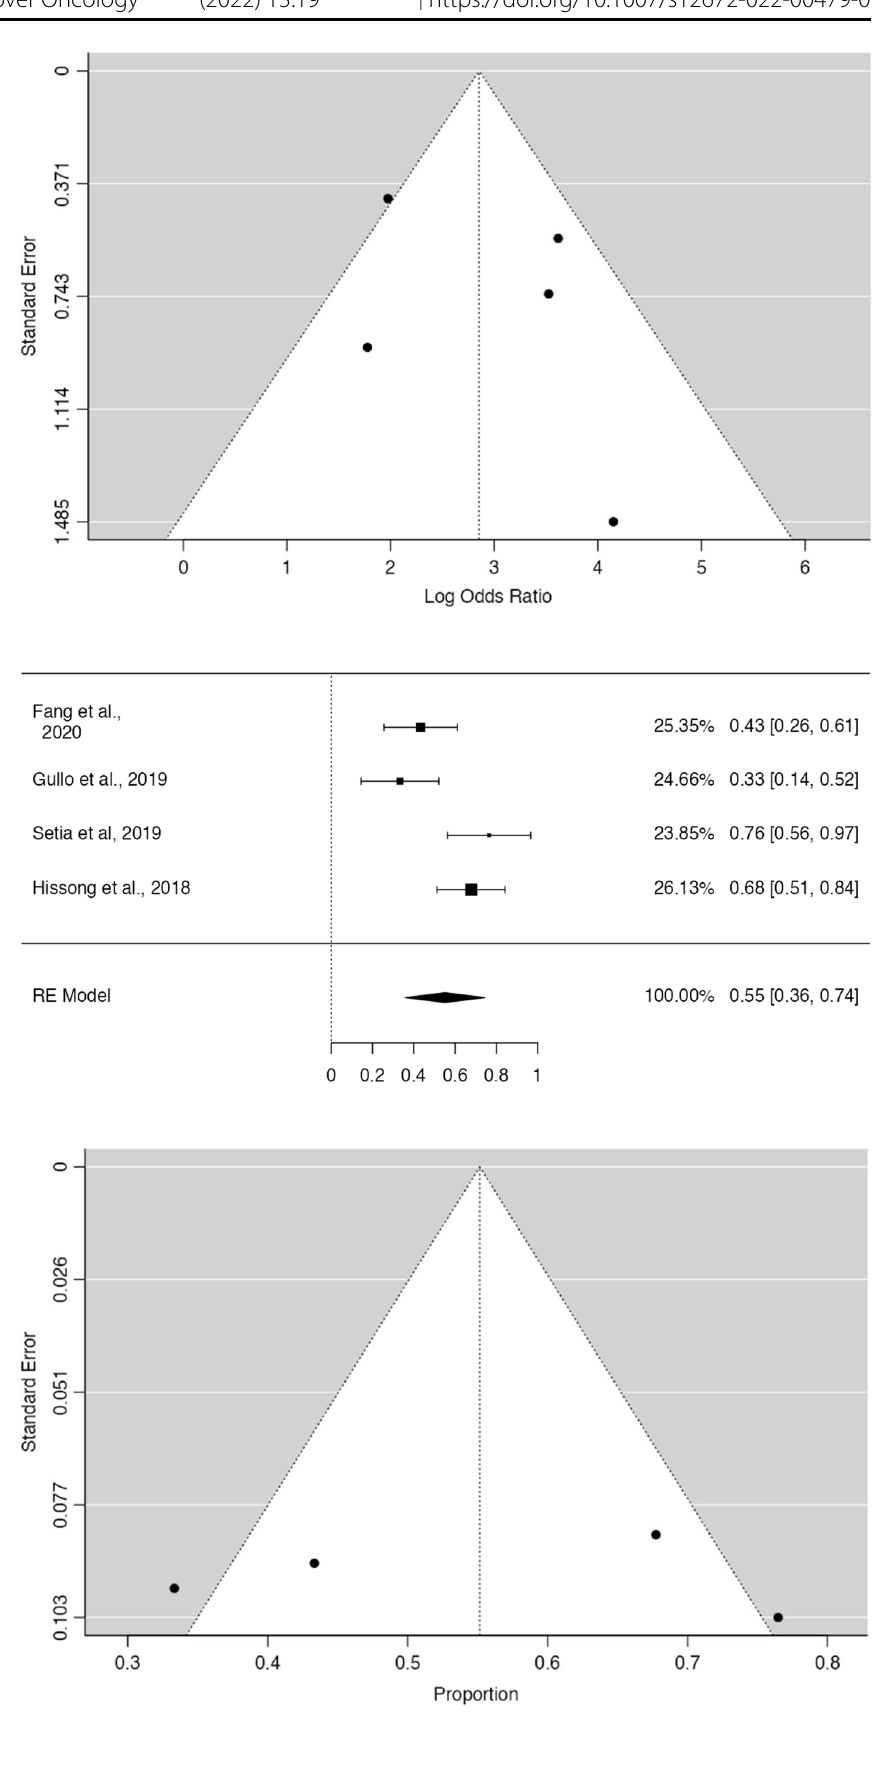
Fig. 9 Funnel-plot on the log(OR) related to EBV expres- sion on GCLS